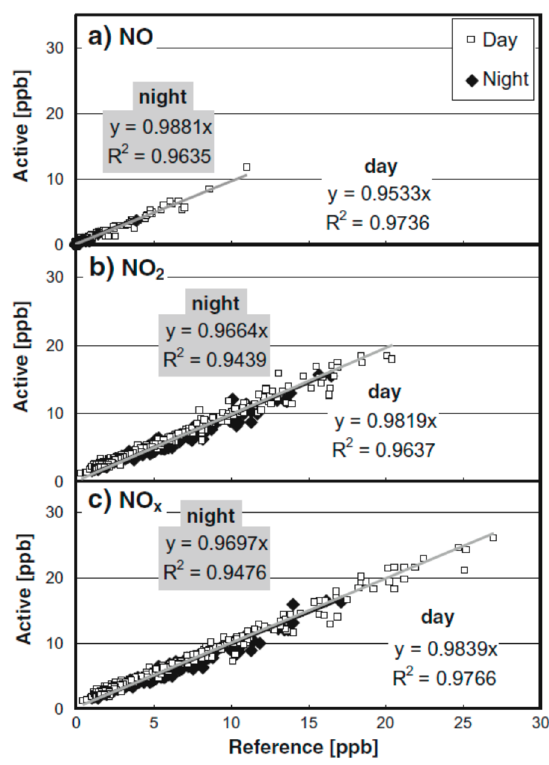
Figure 57. Plots of the 10 min averaged data from the active canyon against the reference canyon for NO, NO 2 and NO x gases during nighttime and daytime periods. Reproduced with permission from Gallus et al. [15]. Copyright 2015 by Springer-Verlag Berlin Heidelberg (License No.: 4453120887380). Table 11. Slopes from the plots of daytime and nighttime results for NO, NO 2 and NO x gases from the active canyon versus the reference canyon; a negative value implies a photocatalytic remediation of that pollutant **.